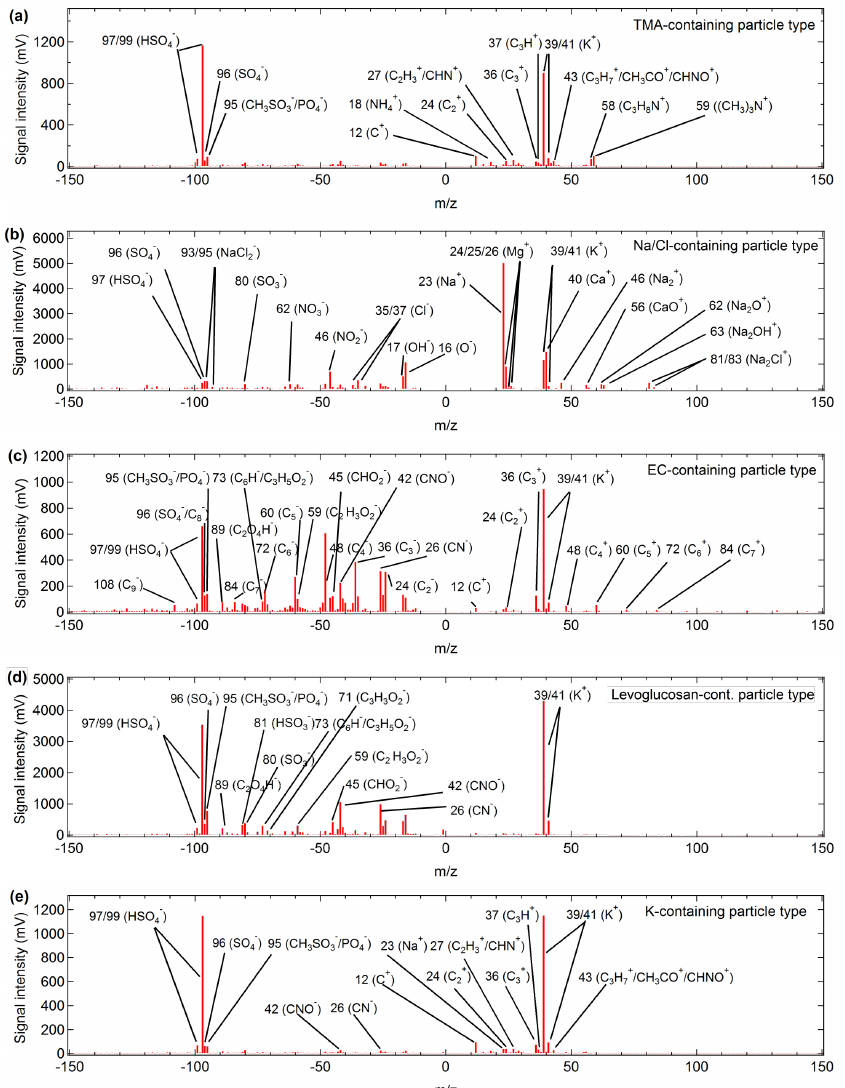
Figure 4. Bipolar mean spectra of the identified particle types: (a) TMA-containing (1688 particles b = 23%), (b) Na / Cl-containing (106 par- ticles b = 1%), (c) EC-containing (138 particles b = 2%), (d) levoglucosan-containing (1312 particles b = 18%) and (e) K-containing (3432 par- ticles b =